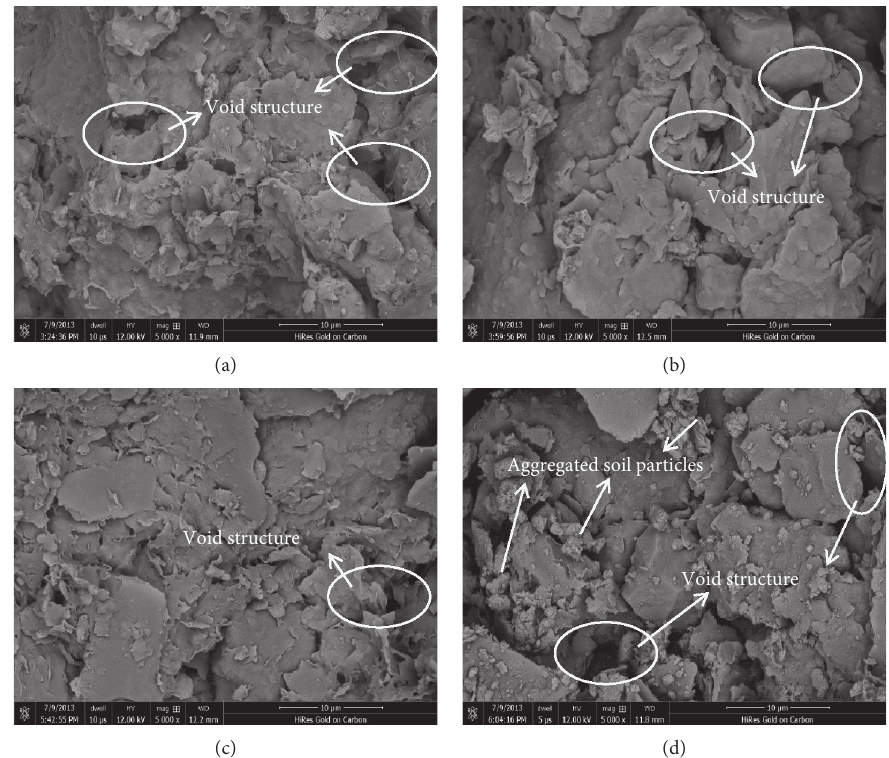
Figure 9: SEM images of lime-stabilized specimens with RAL of 3% under different W-D cycles: (a) 0 W-D cycle; (b) 1 W-D cycle; (c) 5 W-D cycles; (d) 20 W-D